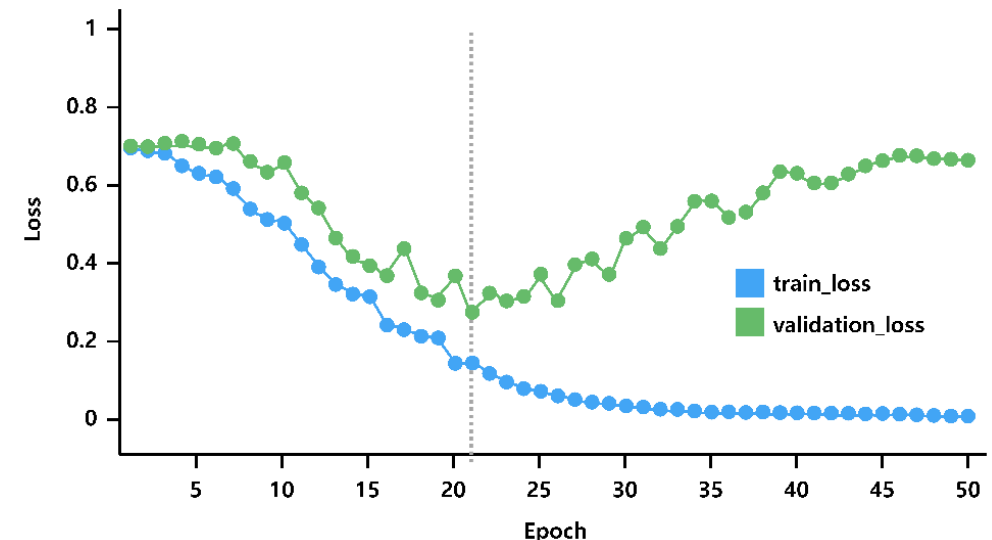
Figure 5. Learning curves in the development set. The gray dotted line presents the lowest loss in validation (0.291).